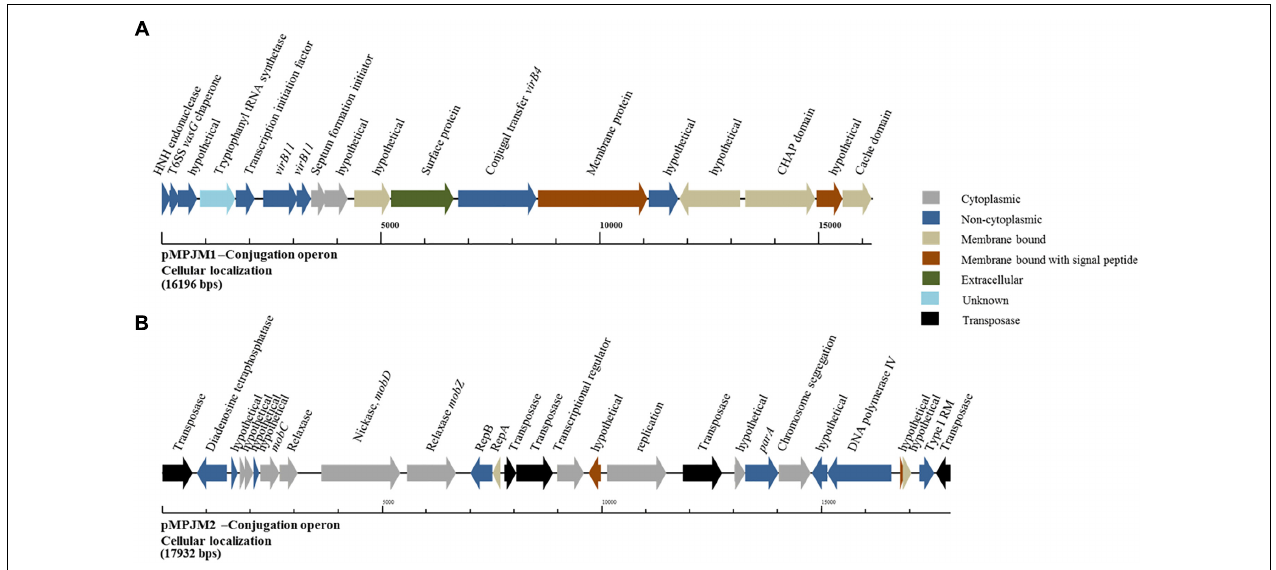
FIGURE 5 | Genetic organization of the putative conjugation gene clusters in pMPJM1 and pMPJM2. (A) Represents the putative conjugation locus in pMPJM1. (B) Represents the putative conjugation locus in pMPJM2. Colors indicate the predicted cellular localization of each product. The system in pMPJM1 appears to encode proteins involved in conjugal transfer, while the cellular localization data is predictive of a transmembrane complex. Conversely, the conjugation locus in pMPJM2 appears to be involved in mobilization rather than conjugation, and the presence of a number of insertion elements suggest it is unlikely to be